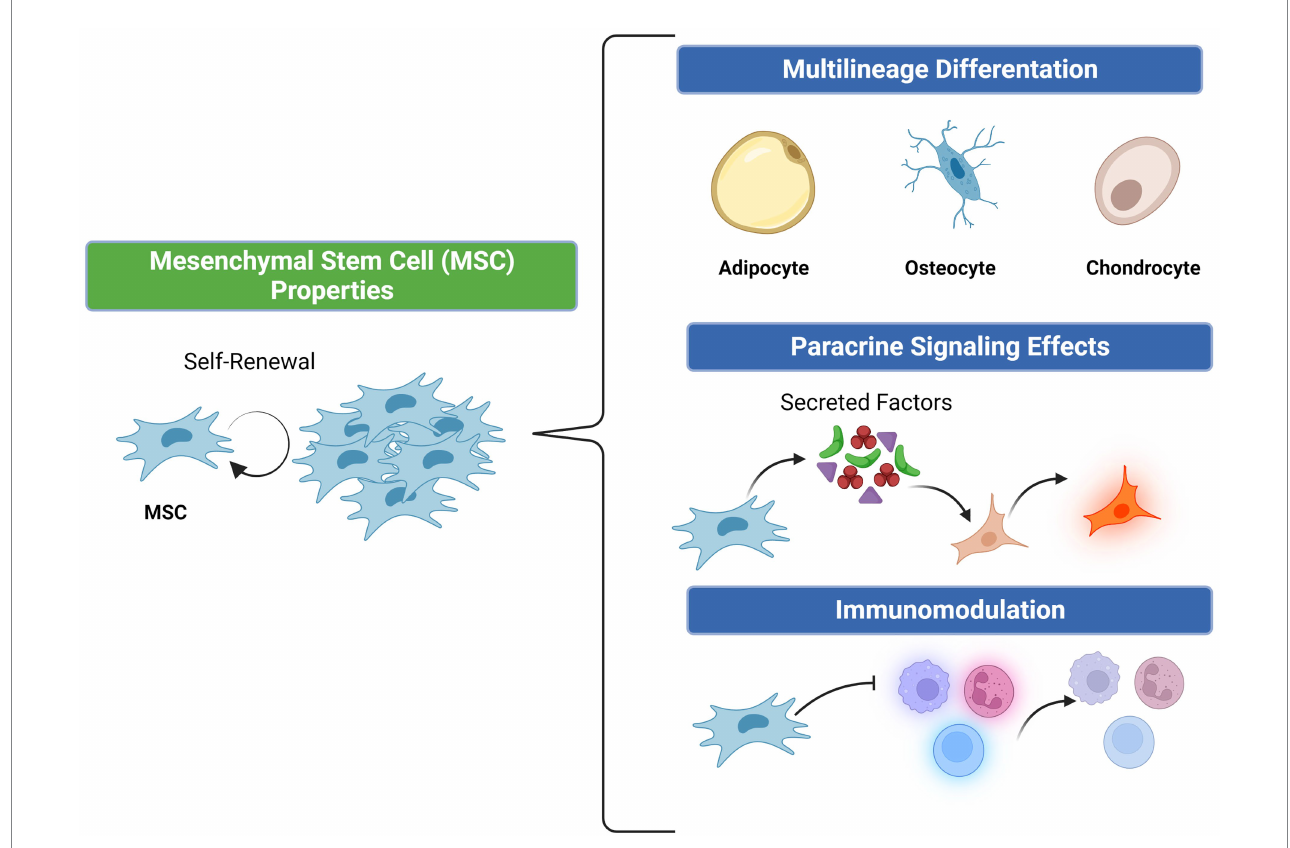
FIGURE 1 Properties of mesenchymal stem